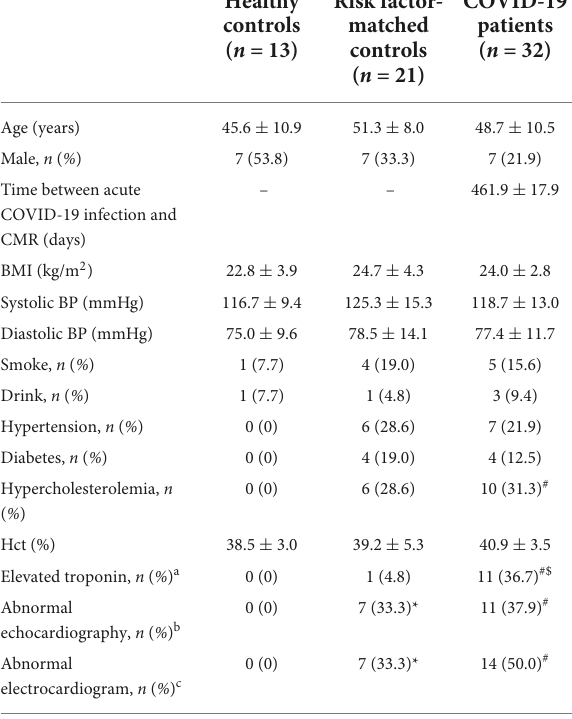
TABLE 1 Demographic and clinical information of all participants. TABLE 2 Cardiovascular magnetic resonance (CMR) imaging findings of all participants.